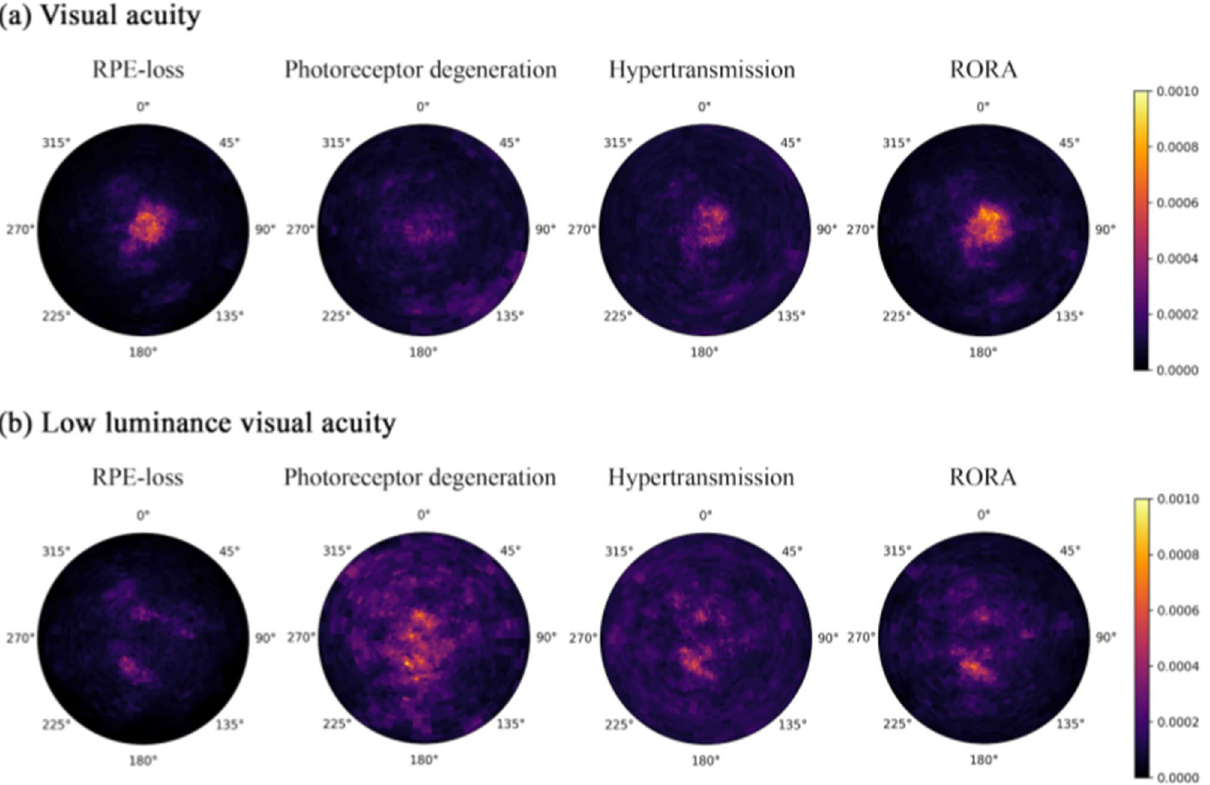
Figure 2. Heatmap of relative feature predictive value. Normalised random forest feature importance as a measure of the predictive value of the four considered features of GA; RPE-loss, photoreceptor degeneration, and hypertransmission and RORA and their locations relative to the fovea to the predicted value for ( a ) standard visual acuity (Overall cohort) and ( b ) low luminance visual acuity (FILLY cohort). Feature importance values were averaged across 100 bootstraps of the